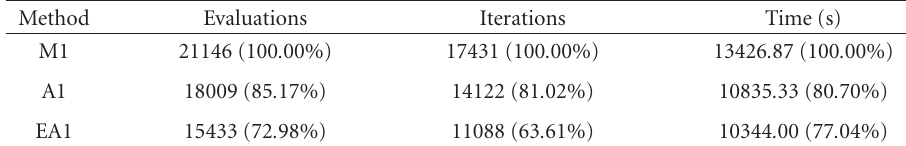
Table 4 . 4 . Results for dimensions from 46 to 80 (134 problems).